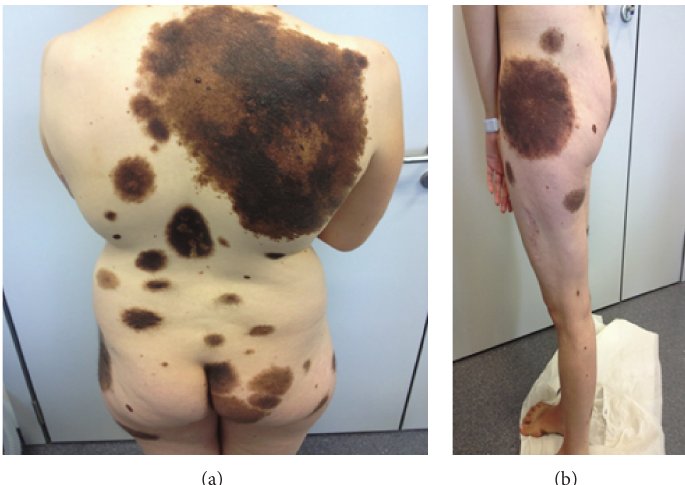
Figure 1: Giant black-brown pigmented nevus, one covering nearly the entire right thoracodorsal region and the other on the left thigh. Note also satellite nevi on the trunk and extremities.